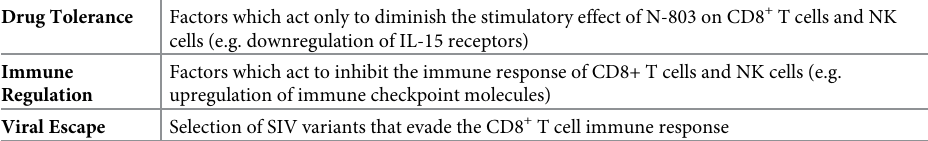
Table 1. Mechanisms considered to compromise N-803